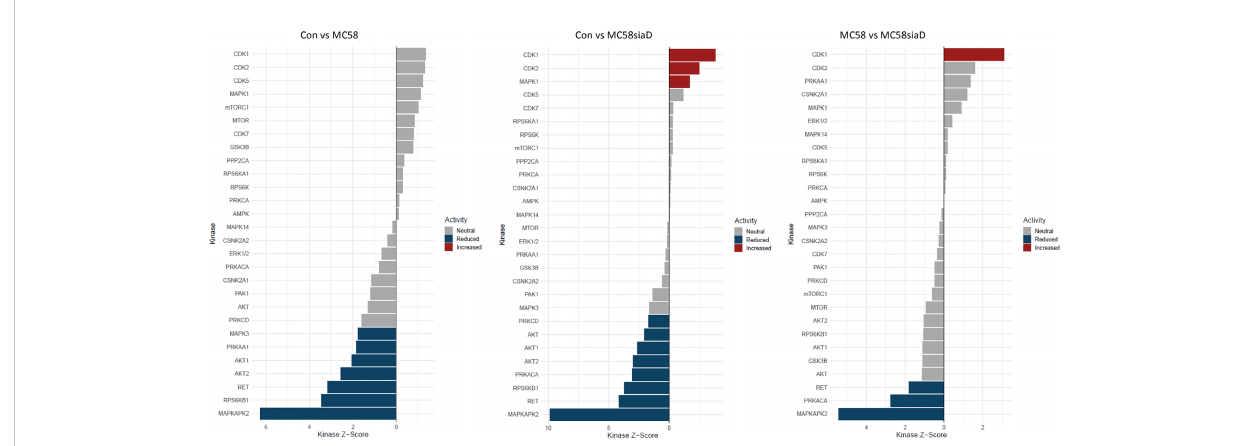
FIGURE 8 Waterfall plot depicting the kinase activity analysis after infection with N. meningitidis wildtype and its capsule-de fi cient mutant. The kinases on the y- axis are ranked by the changes in the phosphorylation sites that are known to be downstream of that speci fi c kinase, the x-axis depicts the kinases respective activity score. The bars are colored if they have a p-value below 0.05, the blue bars depict reduced activity and the red bars signify increased activity. The fi gure has been fi ltered to only include kinases with at least 5 phosphorylated sites mapped to it from the phosphoproteomic